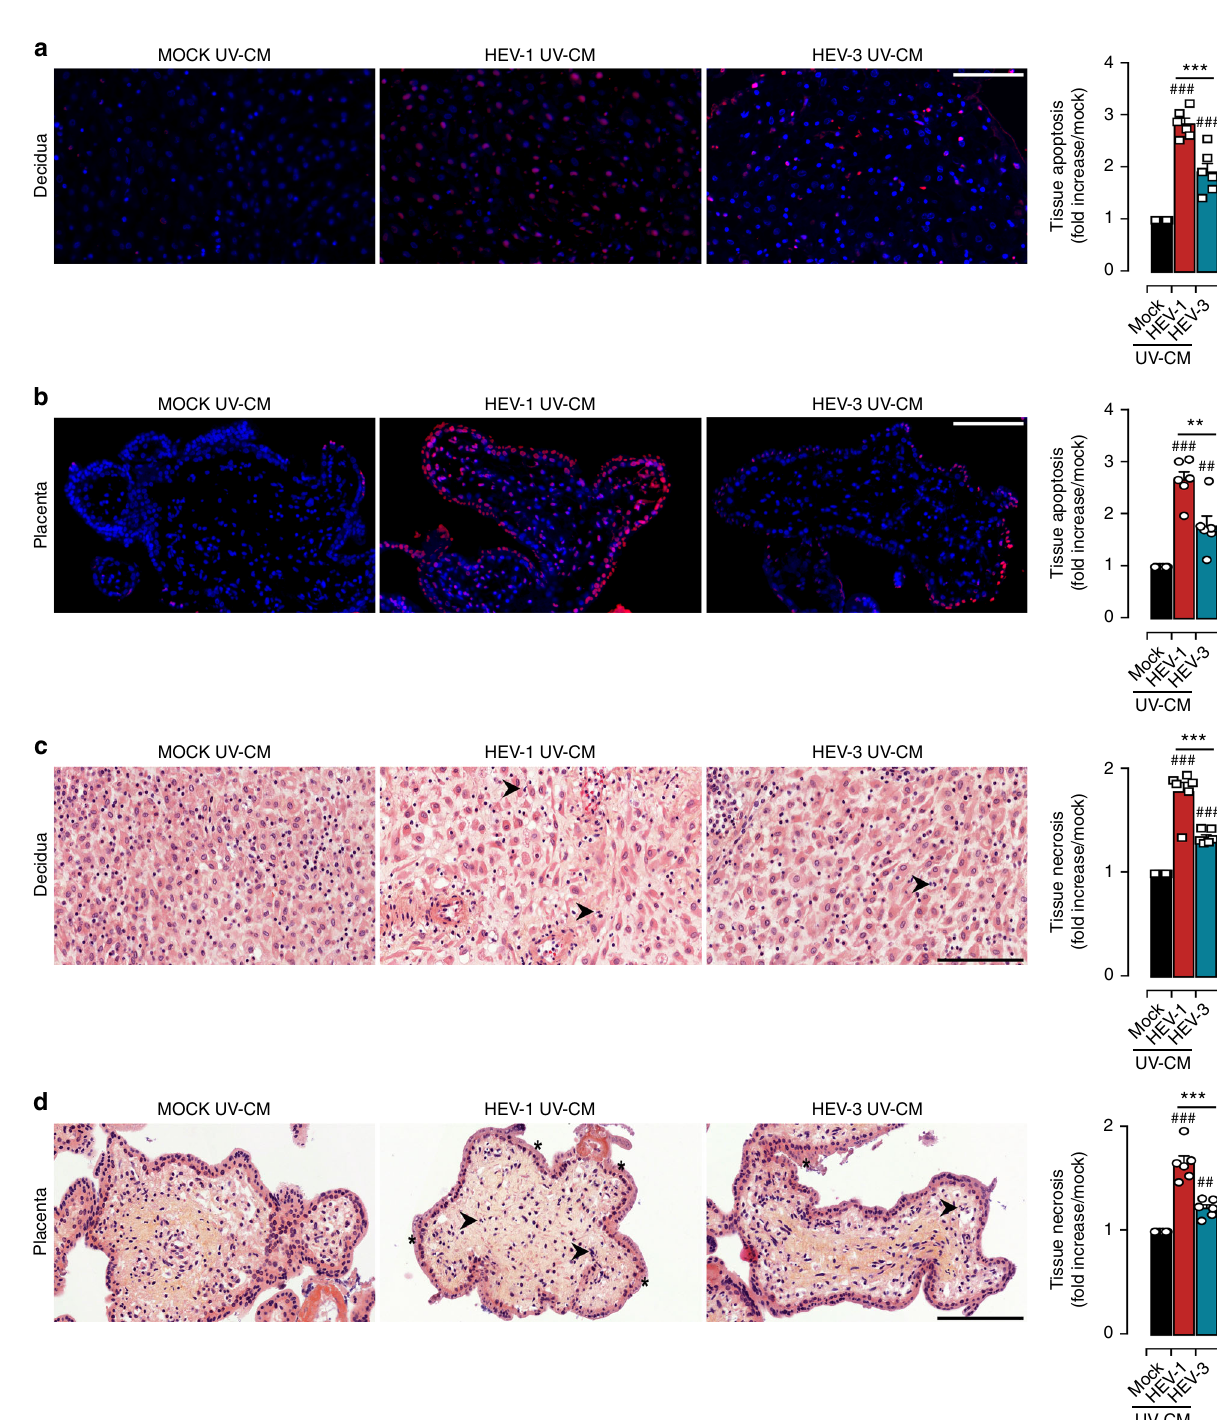
Fig. 4 HEV-1 altered secretome contributes to tissue damage. Histological analyses of apoptosis (TUNEL staining, a , b ) and necrosis (H&E staining, c , d ) and in explants sections prepared from tissues challenged for 5 days with either Mock, HEV-1, or HEV-3 UV-irradiated conditioned media (CM). a , b Representative large fi eld of view of TUNEL stained sections prepared from the decidua a and placenta b . Staining indicates the apoptotic cells (red) and nuclei (blue). Scale bar, 100 µ m. Bar graph illustrates the increase of tissue apoptosis in explants challenged for 5 days with either HEV-1 (red) or HEV- 3 (cyan) UV-CM. Results are normalized to data obtained using UV-CM harvested from mock-infected explants (black) and represented as fold increase. c , d Representative large fi eld of view of H&E stained sections prepared from the decidua c and placenta d . Arrowheads point to necrotic zones with nuclear changes illustrated by pyknosis, karyorrhexis, and karyolysis. Stars indicate an injured syncytiotrophoblast layer. Scale bar, 100 µ m. Bar graph illustrates the increase of tissue necrosis in explants challenged for 5 days with either HEV-1 (red) or HEV-3 (cyan) UV-CM. Results are normalized to data obtained using UV-CM harvested from mock-infected explants (black) and represented as fold increase. Data represent mean values ± S.E.M. of six independent donors. * denotes a statistical comparison between HEV-1 and HEV-3 infected tissues and # represents a statistical comparison between mock and HEV-1 or HEV-3 infected tissues. **/## P < 0.01; ***/### P < 0.001 by repeated measures ANOVA with Tukey post hoc